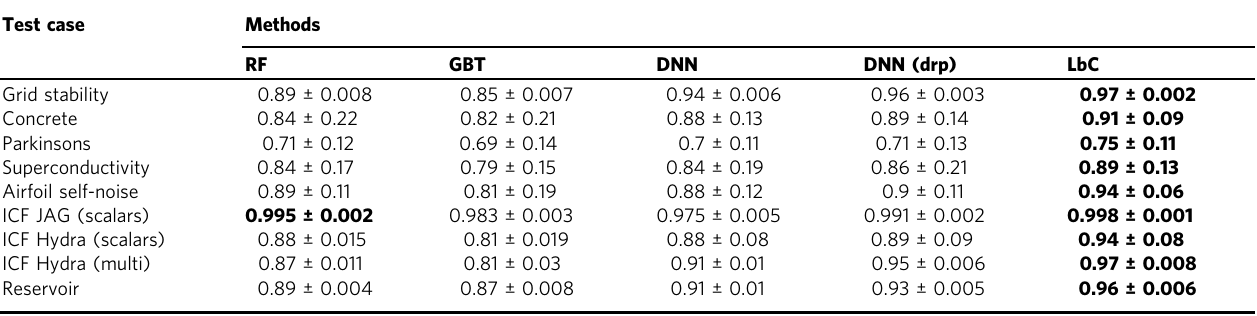
Table 3 Surrogate model performance evaluation using R -squared